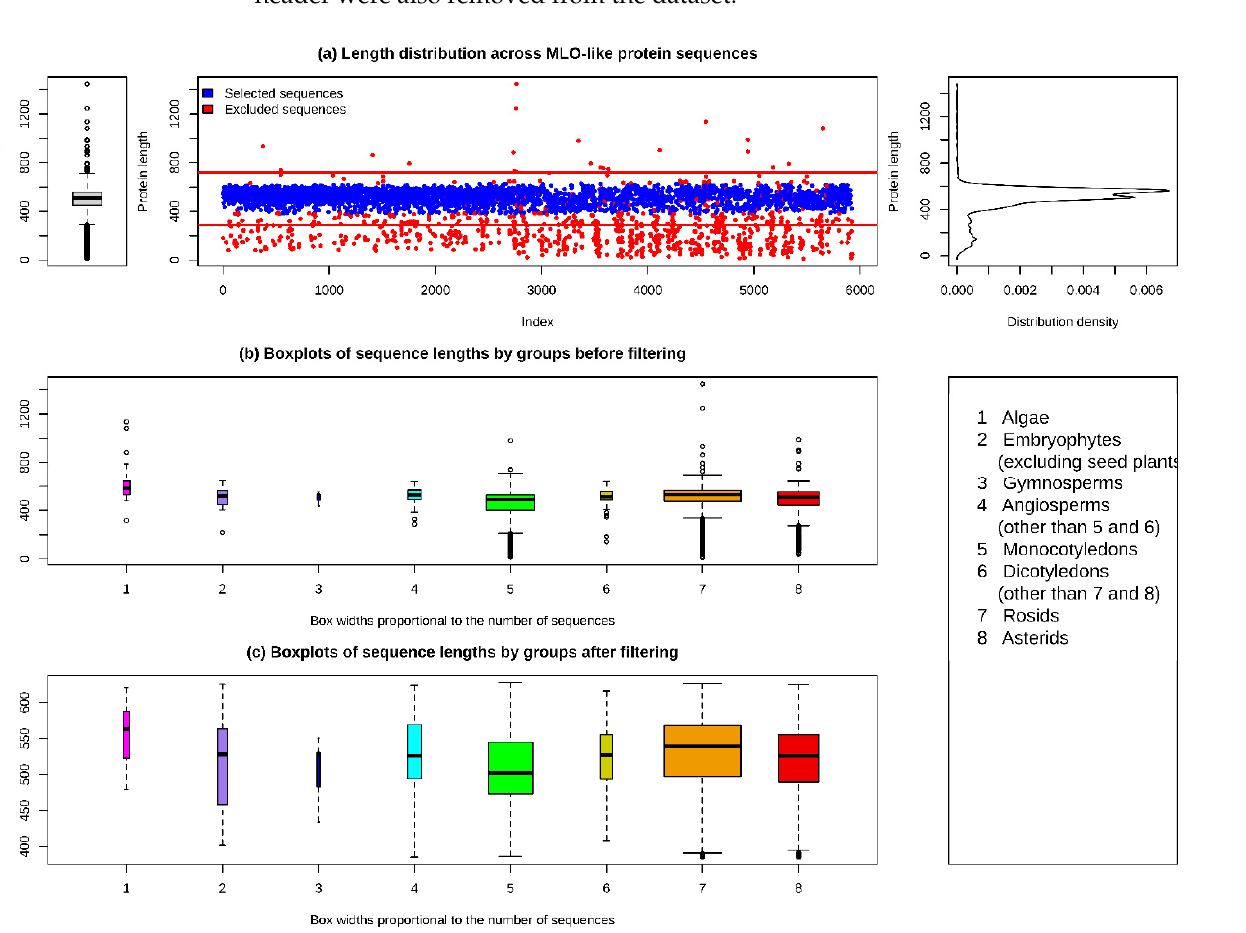
Figure 1. The distribution of sequence lengths in the MLO protein dataset and the results of data filtering.